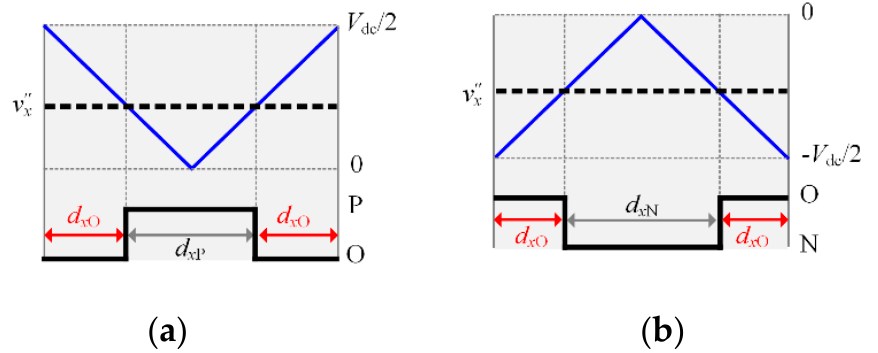
Figure 15. Duty cycles of switching state O of a certain phase in a unit carrier period. ( a ) condition of v ’’ x > 0; ( b ) condition of v ’’ x < 0. The reference voltage, output current and the neutral point current can be regarded as the function of the phase angle θ . Taking sector S I as an example, when the reference voltage is in region R I , phase B is clamped to switching state O and d BO = 1. Substituting (7), (8) and (9) into (10), yields: